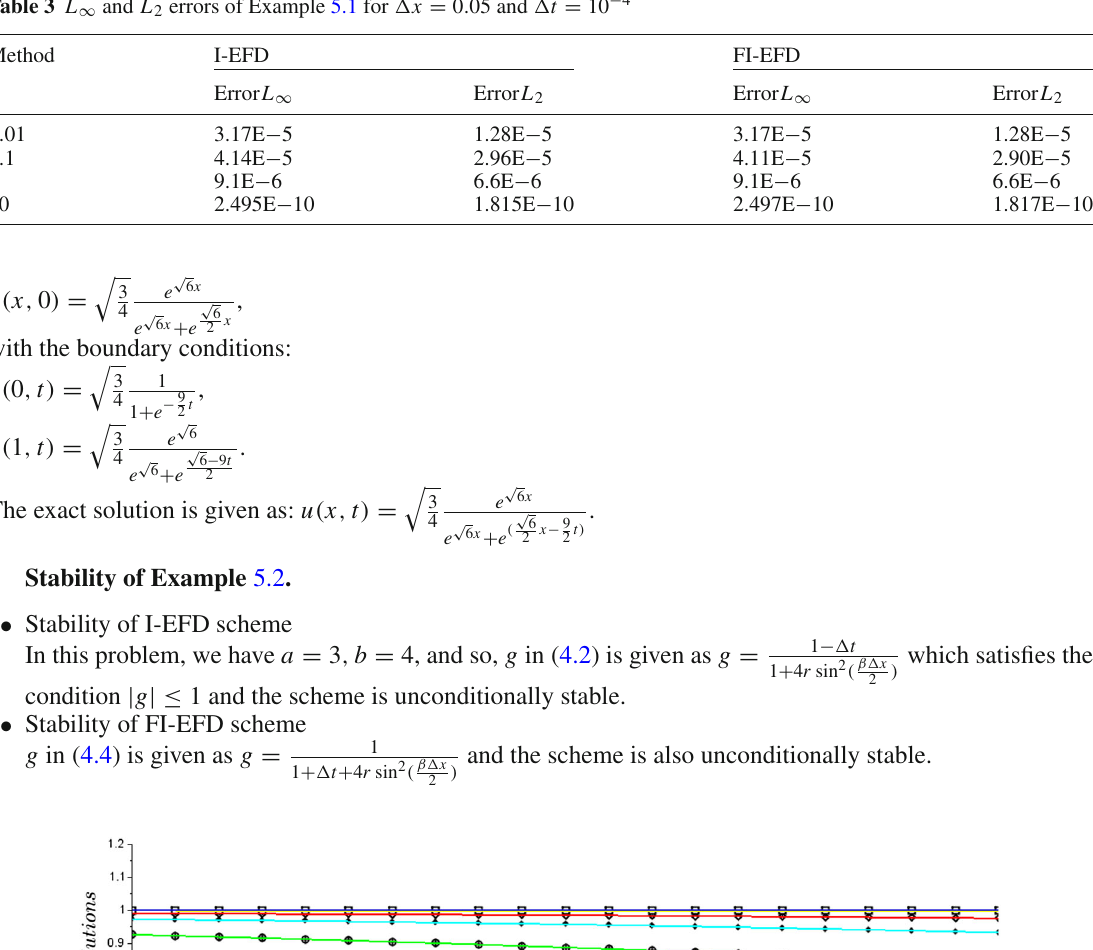
Table 3 L ∞ and L 2 errors of Example 5.1 for (cid:2) x = 0 . 05 and (cid:2) t = 10 − 4